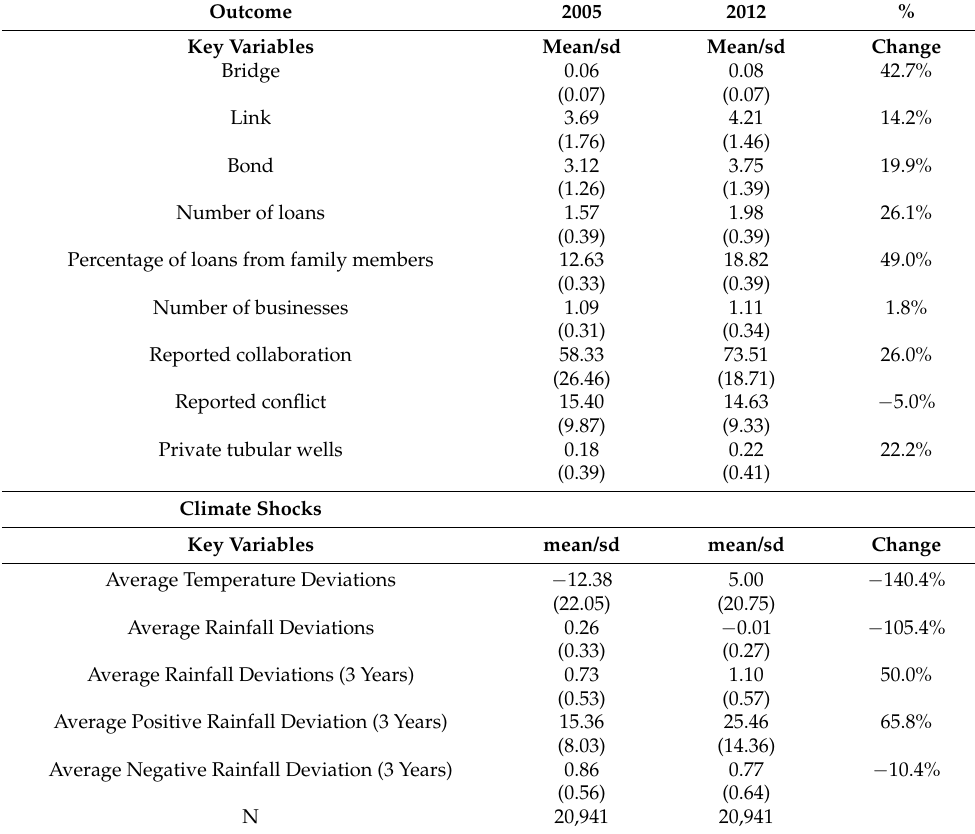
Table 1. Summary statistics of the key outcome variables and key climate